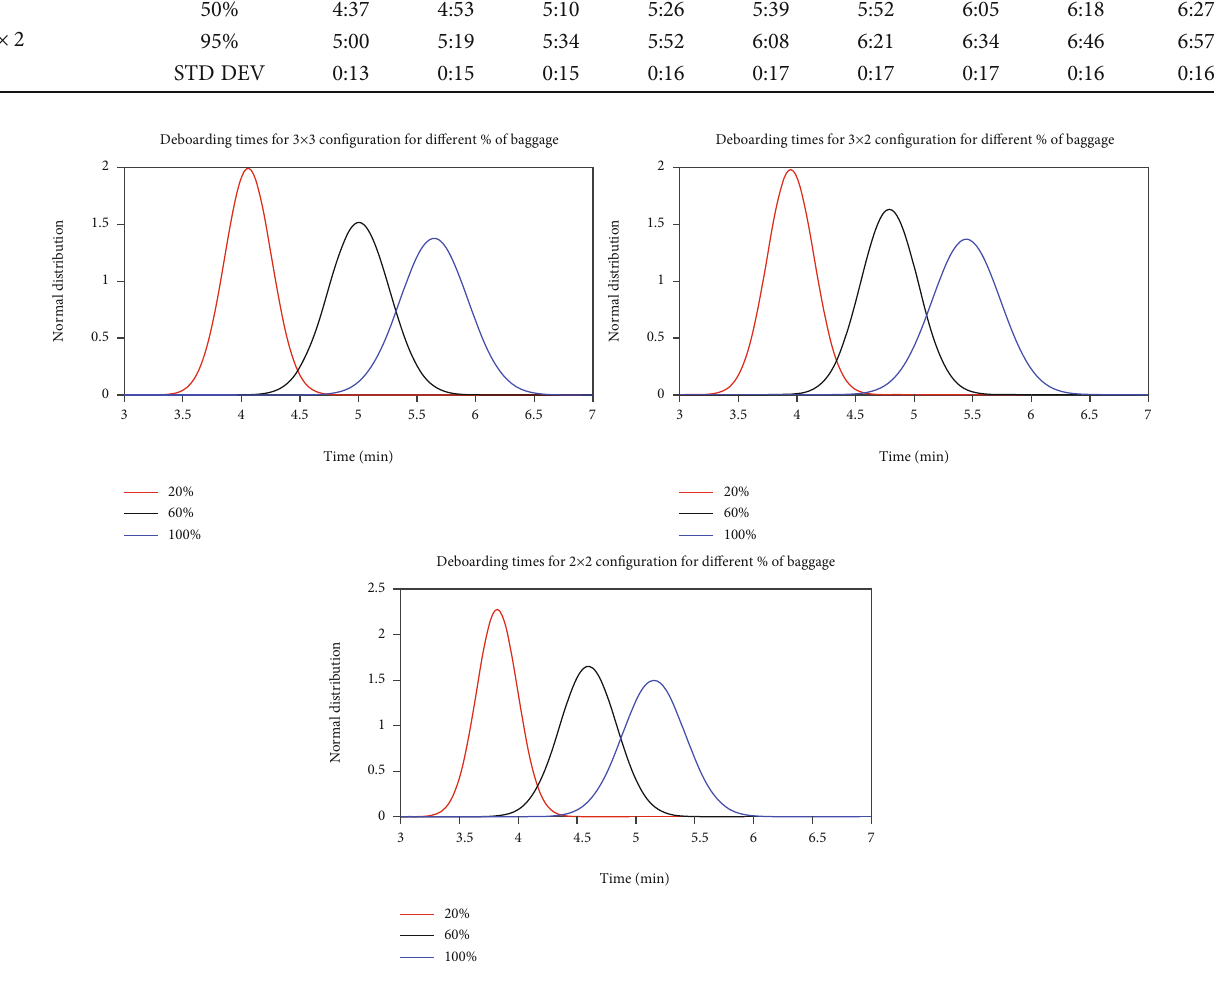
Figure 15: Fitted normal distribution curves for deboarding for the three aircraft con fi gurations for di ff erent % of baggage.